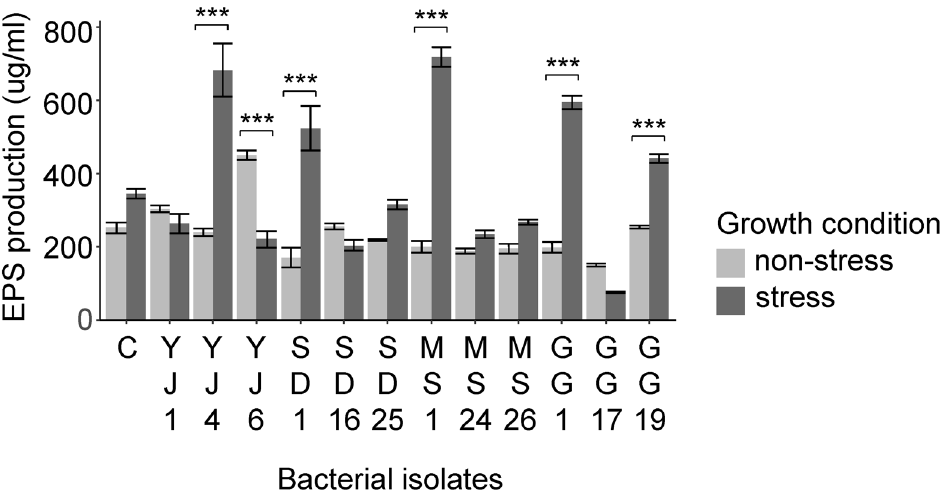
Figure 4. Exopolysaccharides (EPS) production (mean ± SE) of isolates under non-stress and stress conditions, measured in µg/mL. C, Escherichia coli